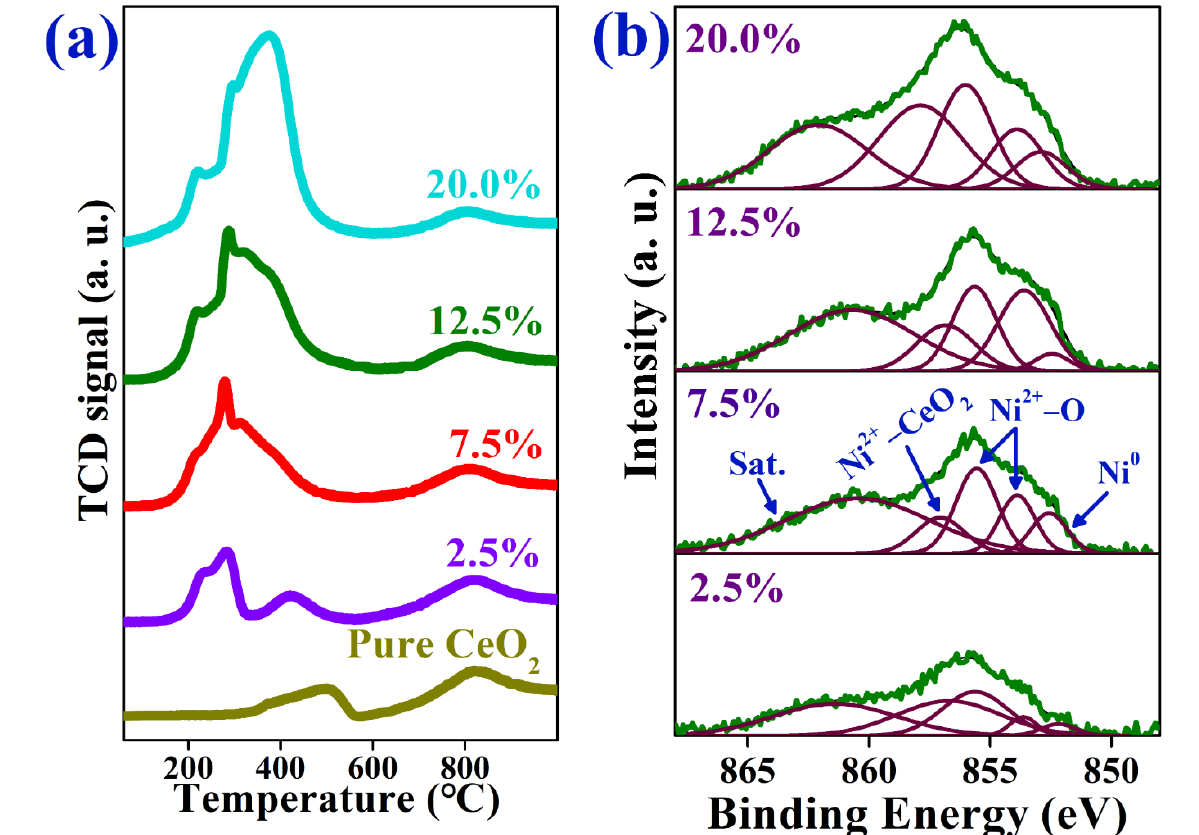
Figure 5. ( a ) H 2 –TPR profiles of pure CeO 2 and Ni@CeO 2 catalysts prepared at different Ni-loadings (2.5, 7.5, 12.5, and 20 wt%). ( b ) XPS spectra of Ni 2p in reduced Ni@CeO 2 catalysts prepared at different Ni-loadings (2.5, 7.5, 12.5, and 20 wt%).